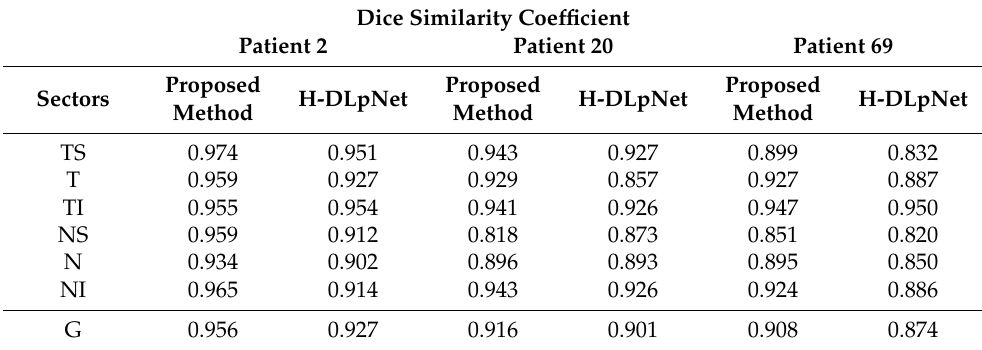
Table 3. Dice similarity coefficient calculated comparing the manual segmentation of the expert with results of the proposed method and H-DLpNet method for each sector of the eye and for the whole layer, G, for the right eye of patients 2, 20, and 69.